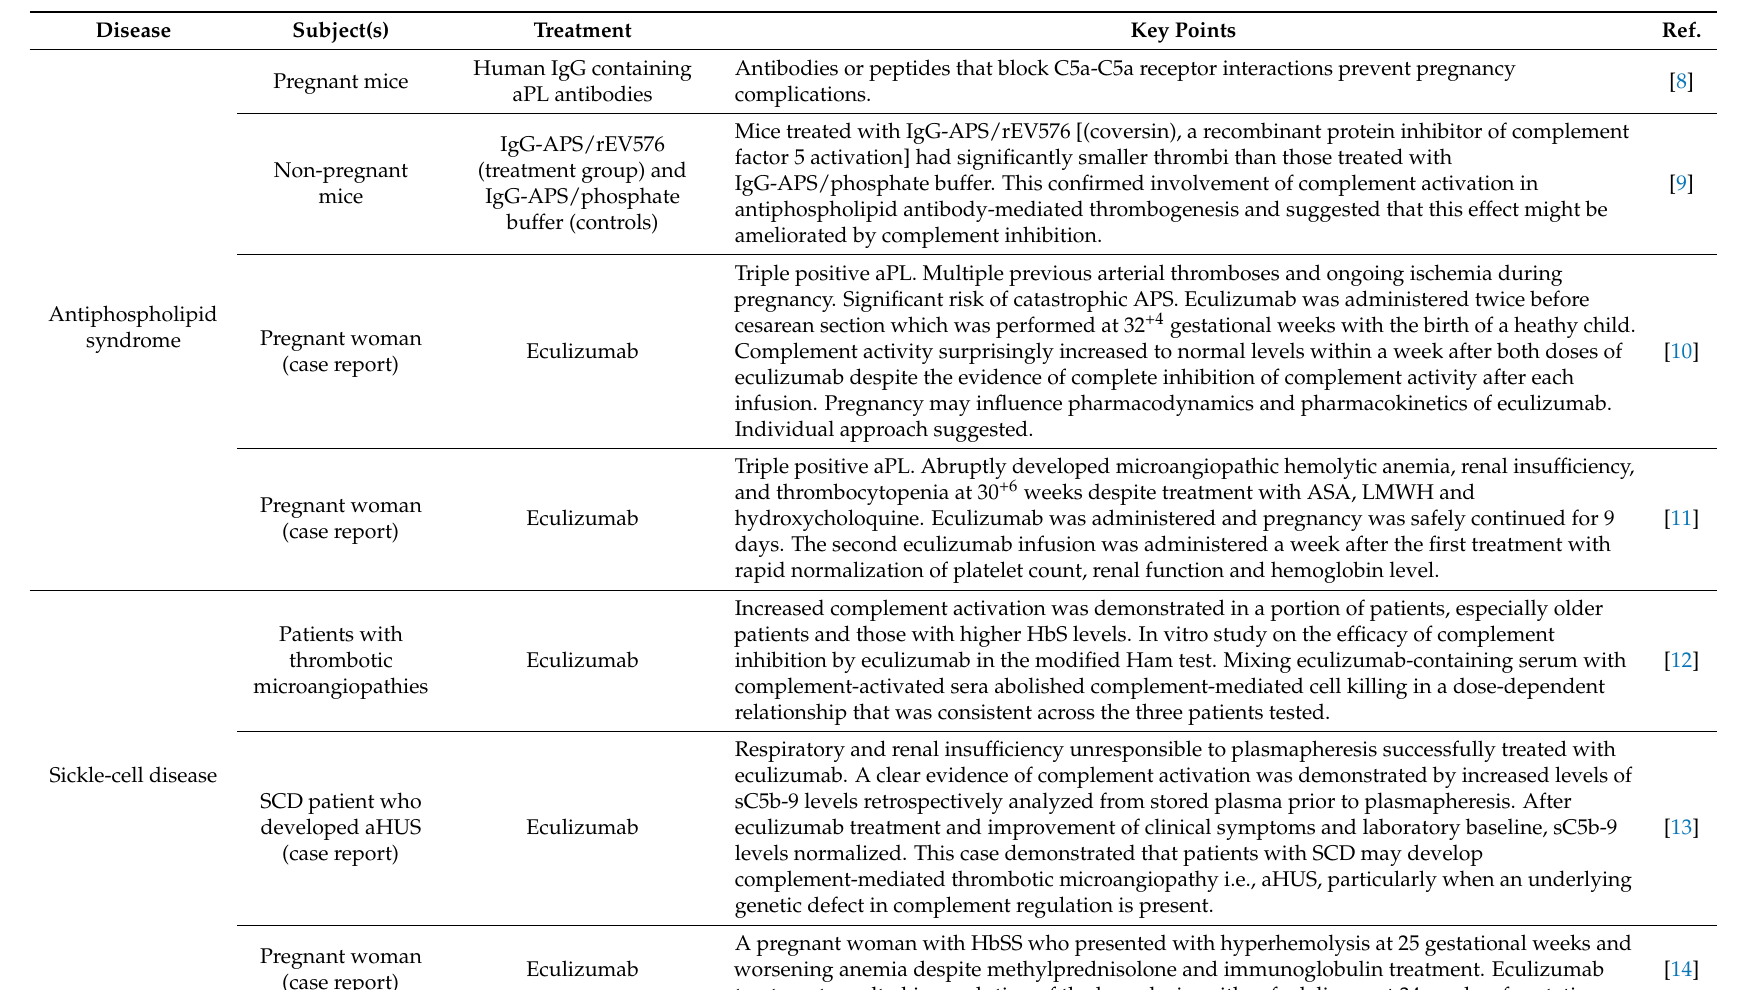
Table 1. Key references demonstrating complement activation in antiphospholipid syndrome, sickle-cell disease, and HELLP syndrome (potential extended indications for eculizumab